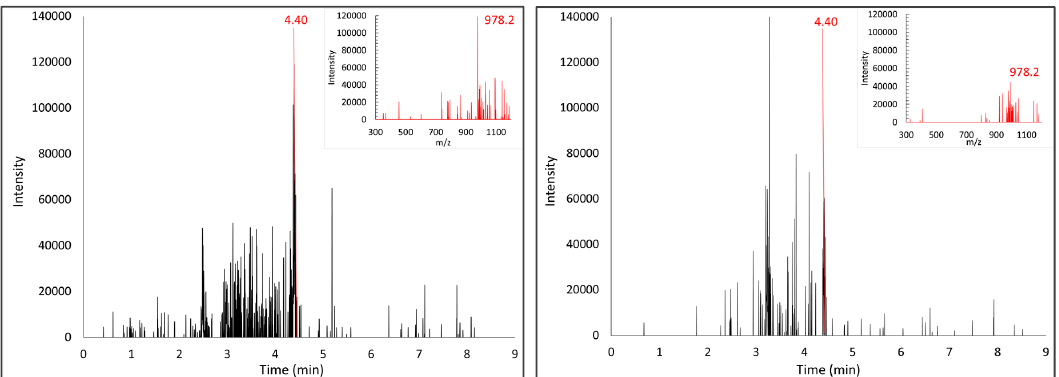
Figure 5. Left panel: Chromatographic profile and the mass spectrum of [MH +4 = 978,2] of 33-mer peptide in chymo-gliadin. Right panel: Chromatographic profile and the mass spectrum corresponding to the same retention time of expected [MH +4 = 978,2] of chymo-gliadin after probiotic digestion.